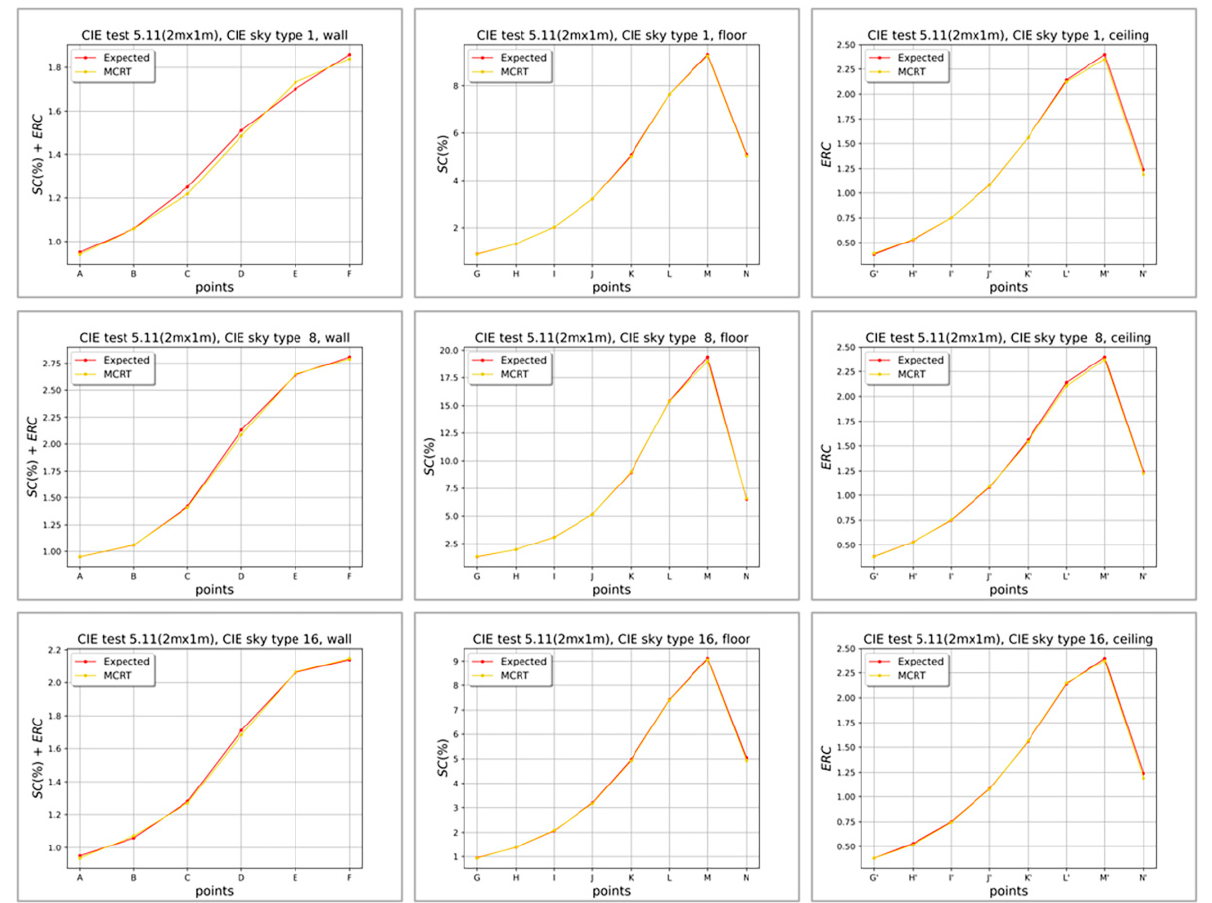
Figure 10. Results of test 5.11 from CIE 171:2006. The yellow line represents the result of Lumicept software (Forward Monte Carlo ray tracing) and the red line is the reference result specified in CIE 171: 2006. Table 8. Results of test 5.11 from CIE 171:2006. Points A–F on the wall (Figure 9).